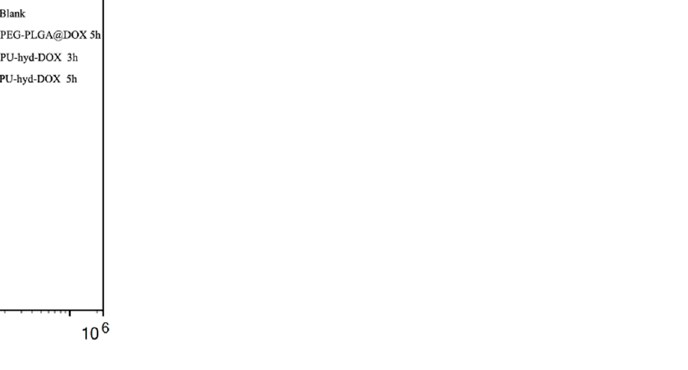
Figure 5. Flow cytometry analysis of cellular uptake in HepG2 cells at pH 7.4 and 37 °C when treated by PEG-PLGA@DOX and PU-hyd-DOX micelles after different incubation times.